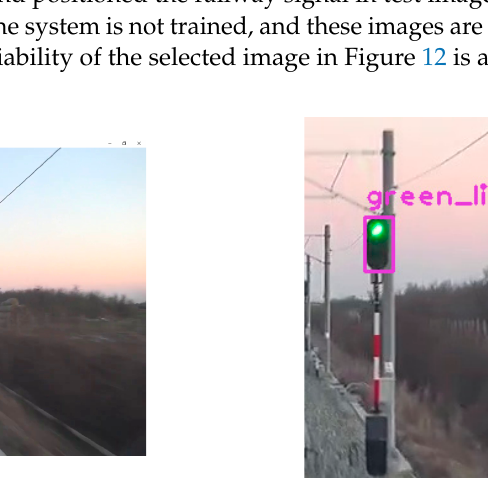
Figure 12. Signal detection—bounding box, class, and system reliability (dataset 150).